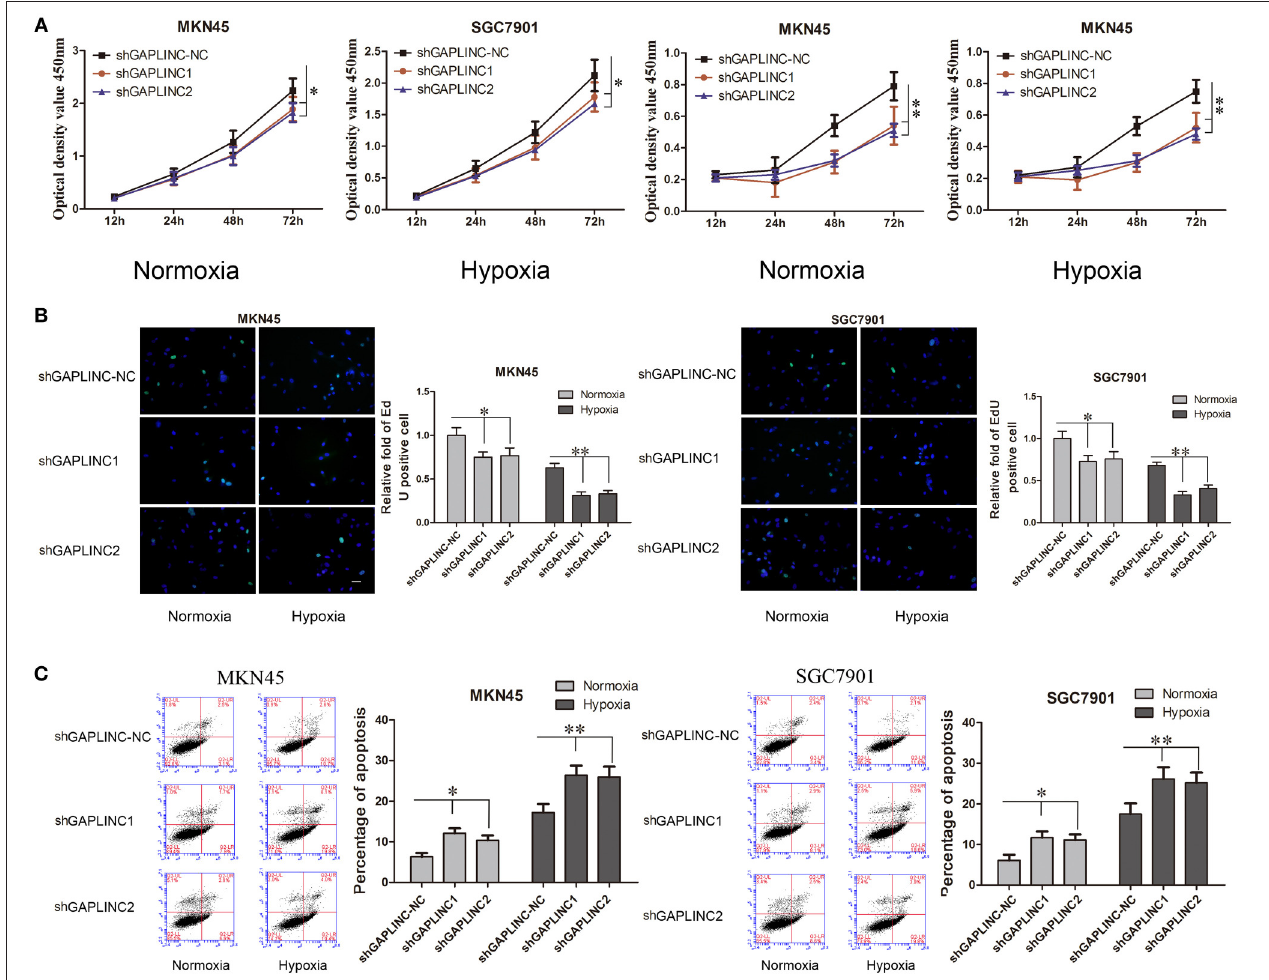
FIGURE 4 | GAPLINC sustained tumor cell growth and decreased cell apoptosis in MKN45 and SGC7901 cells especially under hypoxic conditions. Values represent the mean ± SD. (A) Cell proliferation rates detected using CCK8 reagents. (B) EdU incorporation assay (C) AnnexinV PI/FITC staining in normoxic and hypoxic MKN45 and SGC7901 cells treated with either control or shGAPLINC showing reduced proliferation, reduced DNA replication and increased apoptosis following GAPLINC depletion. The effect was more obvious under hypoxia (* P < 0.05, ** P <